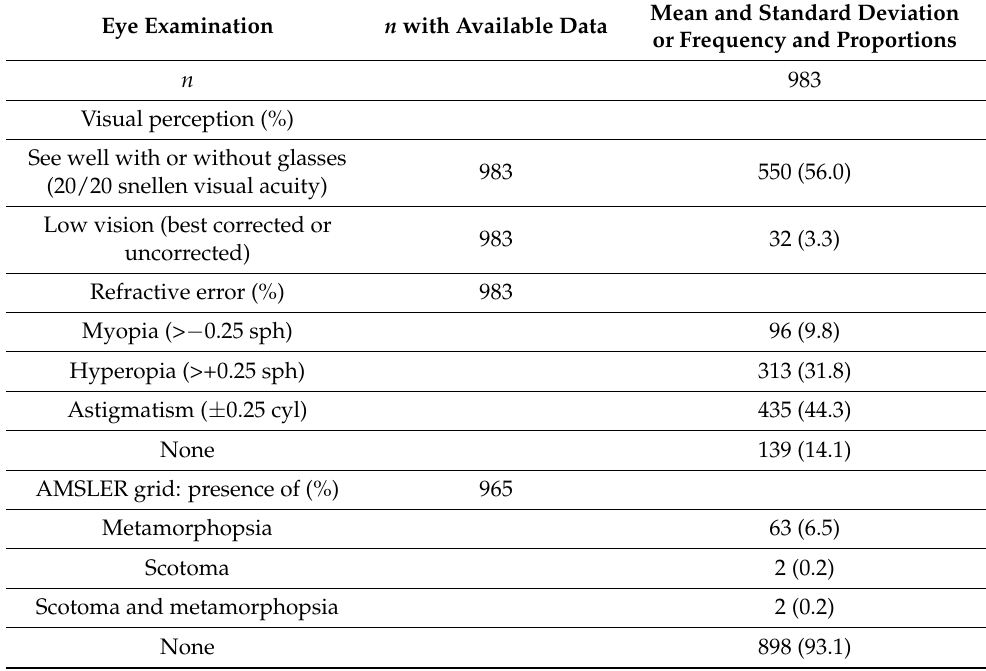
Table 2. General eye health status and prevalence of eye